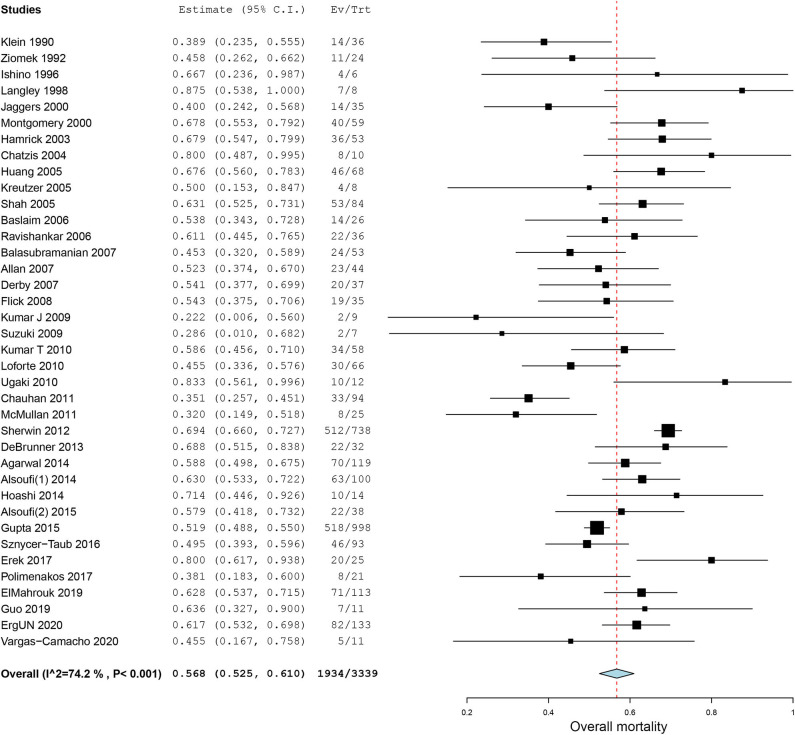
Forest plot of in-hospital mortality for patients receiving extracorporeal membrane oxygenation after congenital heart diseases surgery.